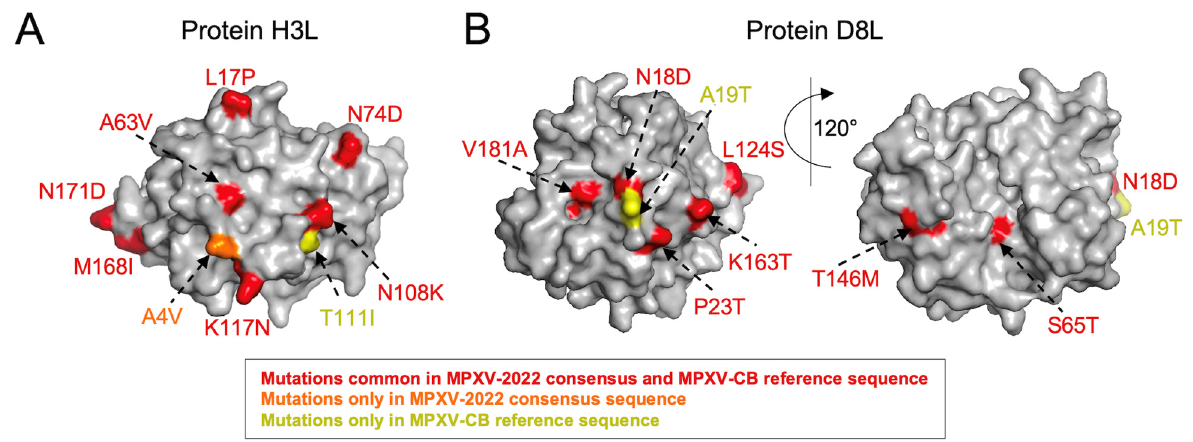
Figure 1. Mapping mutations observed in MPXV-2022 and MPXV-CB on the structure available for VACV ( A ) H3L [PDB ID: 5EJ0] and ( B ) D8L [PDB ID: 4E9O] surface proteins. The core structure of each protein is shown in gray, while mutations and their labels are colored according to the scheme in the legend.